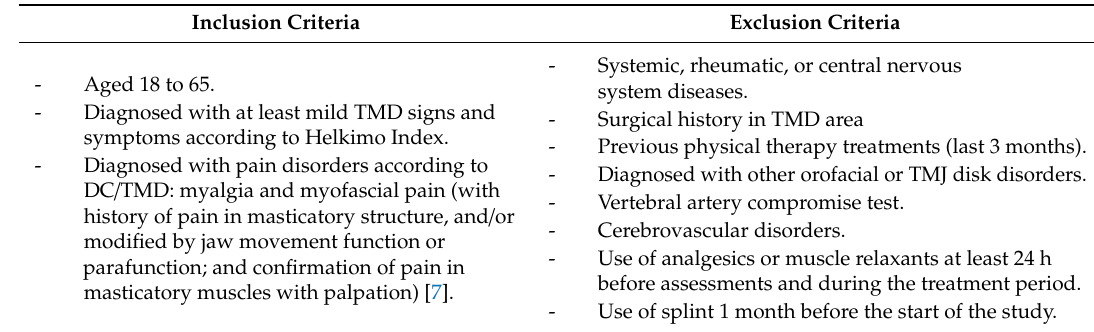
Table 1. Participants inclusion and exclusion